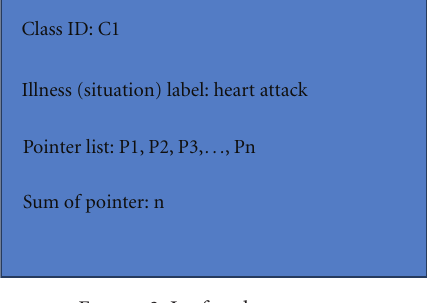
Figure 3: Leaf node